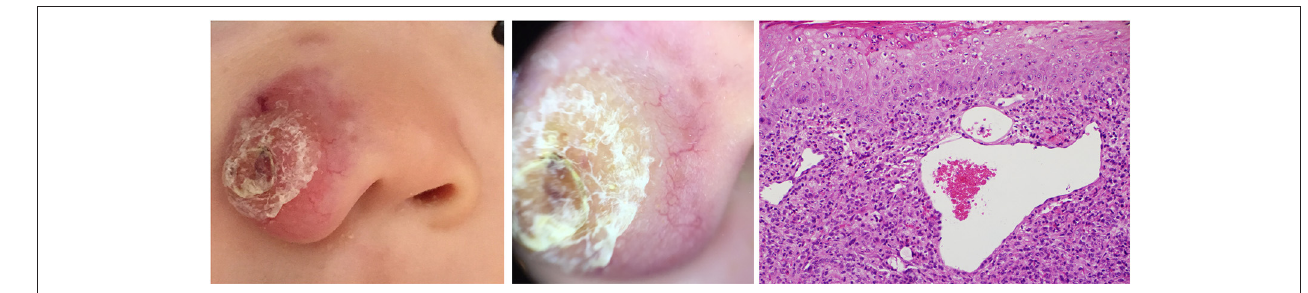
FIGURE 7 | Early stage of JXG (Right) , H&E original magnification x20 with clinical (Left) and dermoscopic (Middle) correlations.